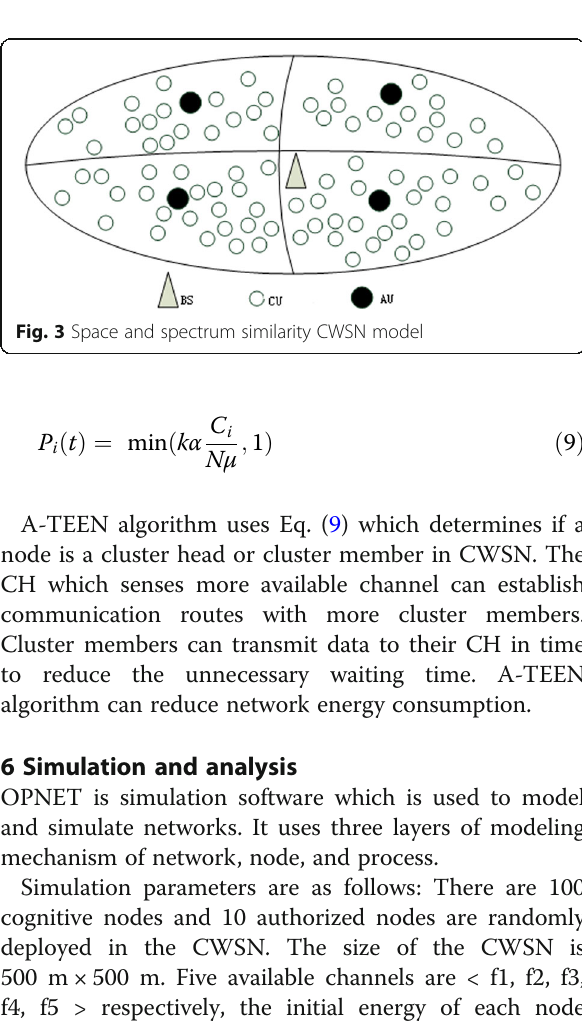
Fig. 5 The node model of authorized